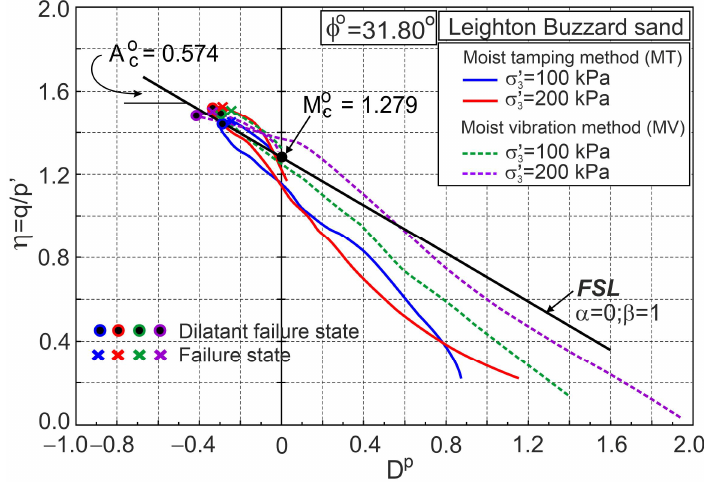
Figure 10. Stress ratio–plastic dilatancy relationships for pure Leighton Buzzard sand (based on the experimental data from [34]).